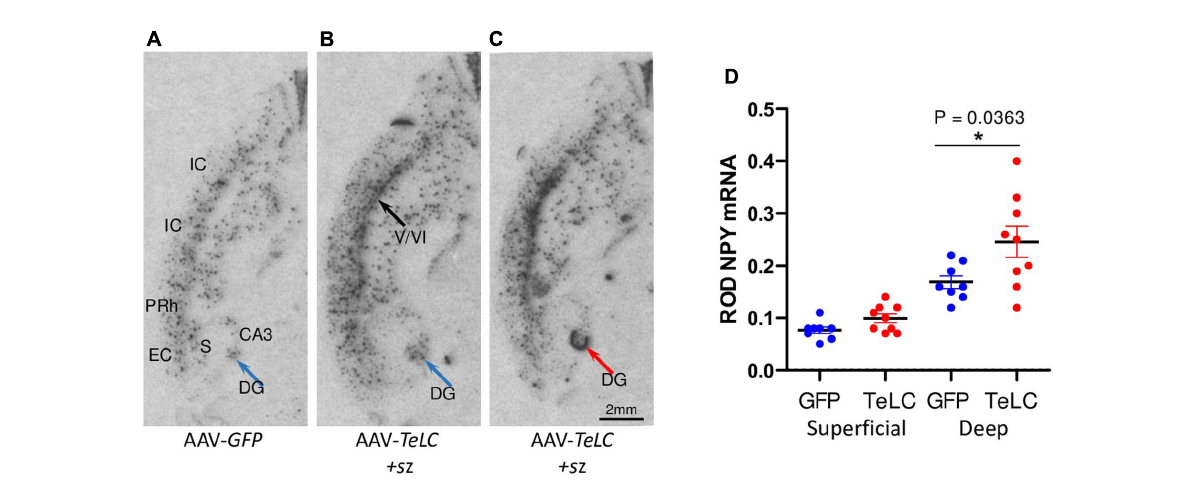
FIGURE6 NPY mRNA expression in the deep layers of the cerebral cortex. Mice injected with AAV- GFP or AAV- TeLC were sacrificed after 6 weeks and brains were subjected to in situ hybridization. The images were obtained in horizontal sections showing the ventral hippocampus and adjacent limbic cortex areas (insular, perirhinal, entorhinal cortices). (A) AAV- GFP -injected control; (B) AAV- TeLC -injected mouse that exposed five SRS between days 6–25; (C) AAV- TeLC -injected mouse that exposed four SRS on days 3 and 2 before sacrificing (day 42). Black arrow in panel (B) denotes NPY mRNA expression in the deep cortical layers; blue arrow in panel (B) points to interneurons in the dentate hilus expressing NPY mRNA; red arrow in panel (C) denotes massive de novo NPY mRNA expression in the granule cell layer. (D) Quantification of NPY mRNA in the deep and superficial cortical layers 6 weeks after AAV- GFP and AAV- TeLC injection. Data are shown as mean ± SEM. Statistics (Student’s t -test) was performed using the GraphPad Prism program. In interneurons of the deep layers (V/VI) but not in the superficial layers (layers II/III) of the insular, perirhinal and entorhinal cortices, NPY mRNA was significantly increased ( P = 0.0363, *). Abbreviations: DG, dentate gyrus (hilus); CA3, hippocampal subfield CA3; S, subiculum; IC, insular cortex; PRh, perirhinal cortex; EC, entorhinal cortex.